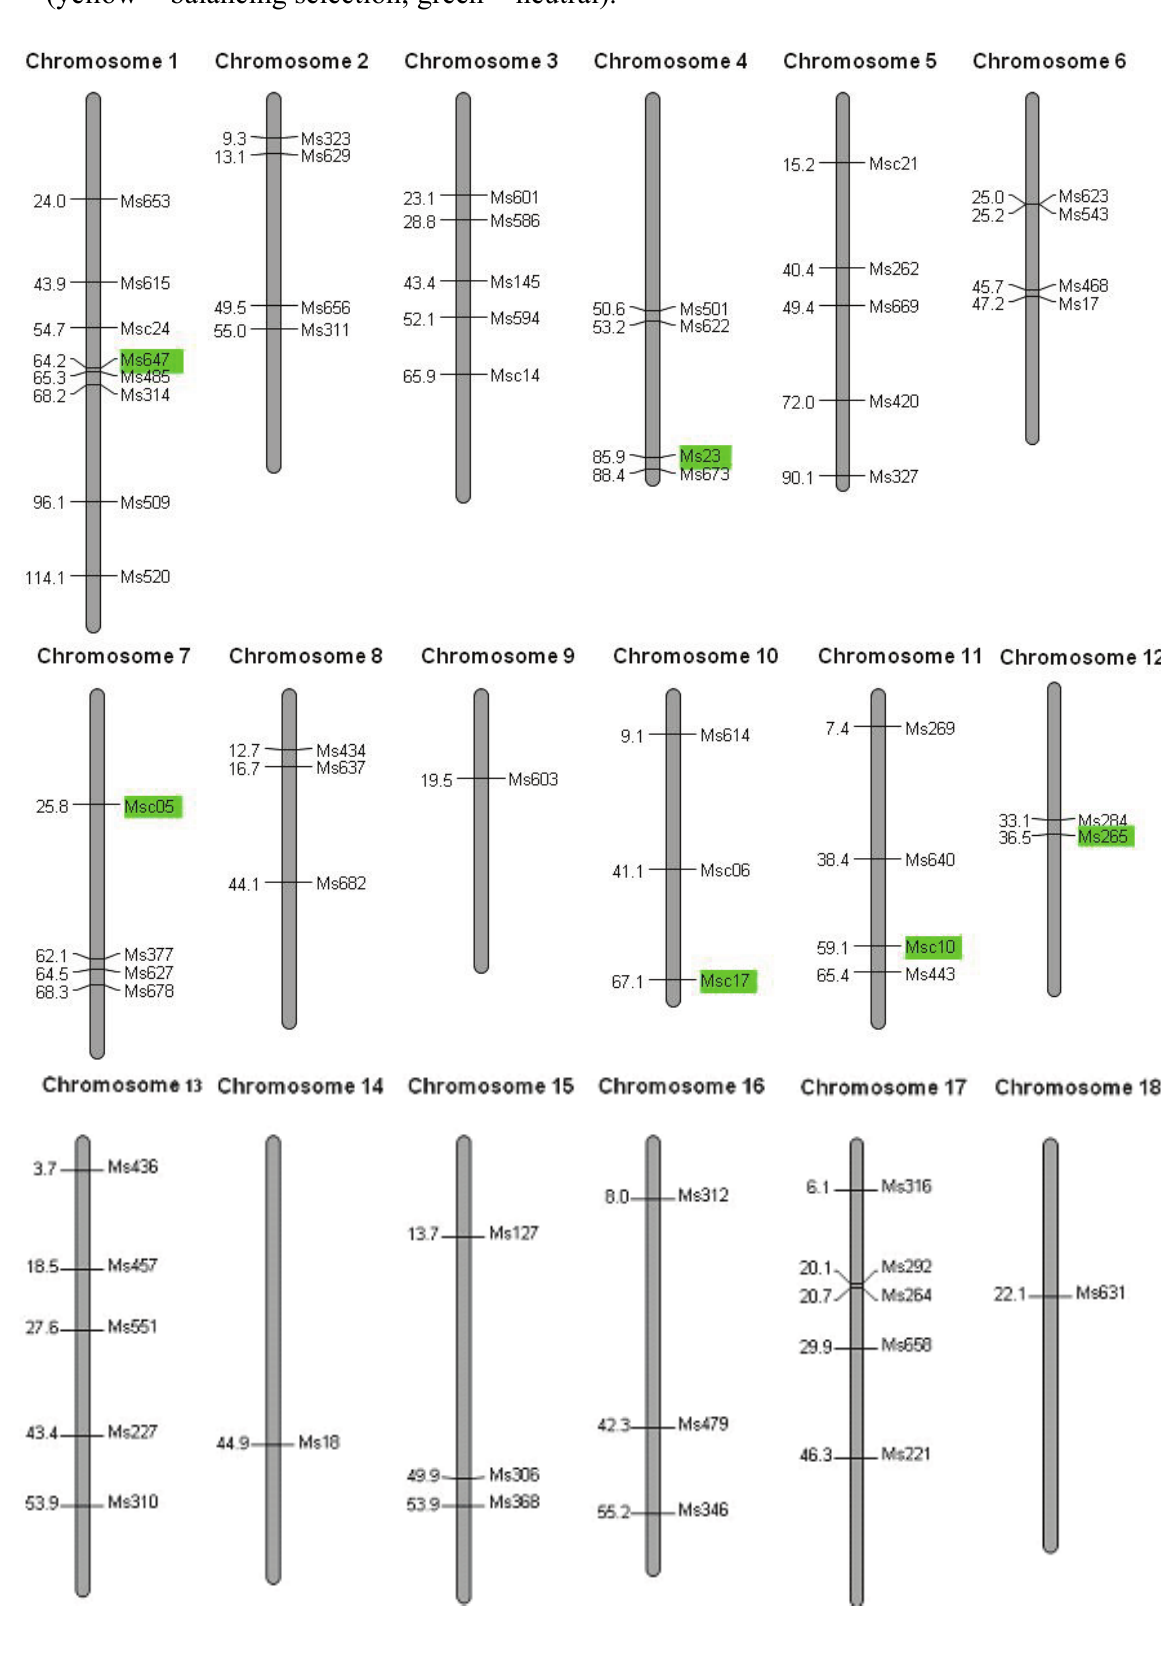
outlier test for selection ST